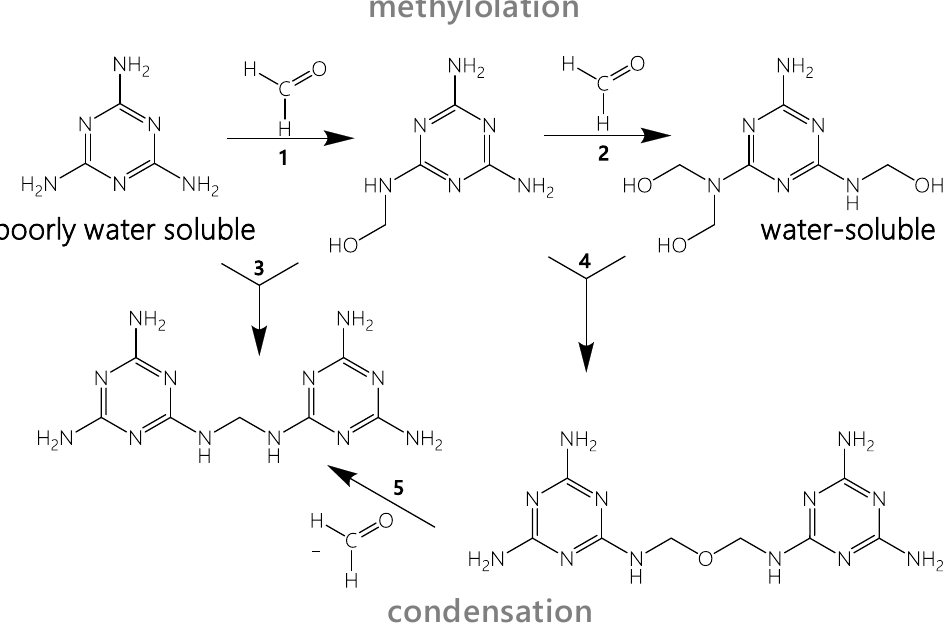
Figure 1. General reactions taking place in MF resins. Methylolation: Water insoluble melamine reacts with formaldehyde to water-soluble methylolated species (1, 2). Condensation: Formation of methylene bridges (3), formation of methylene ether bridges (4) and rearrangement under formaldehyde release (5). Modified from [12].